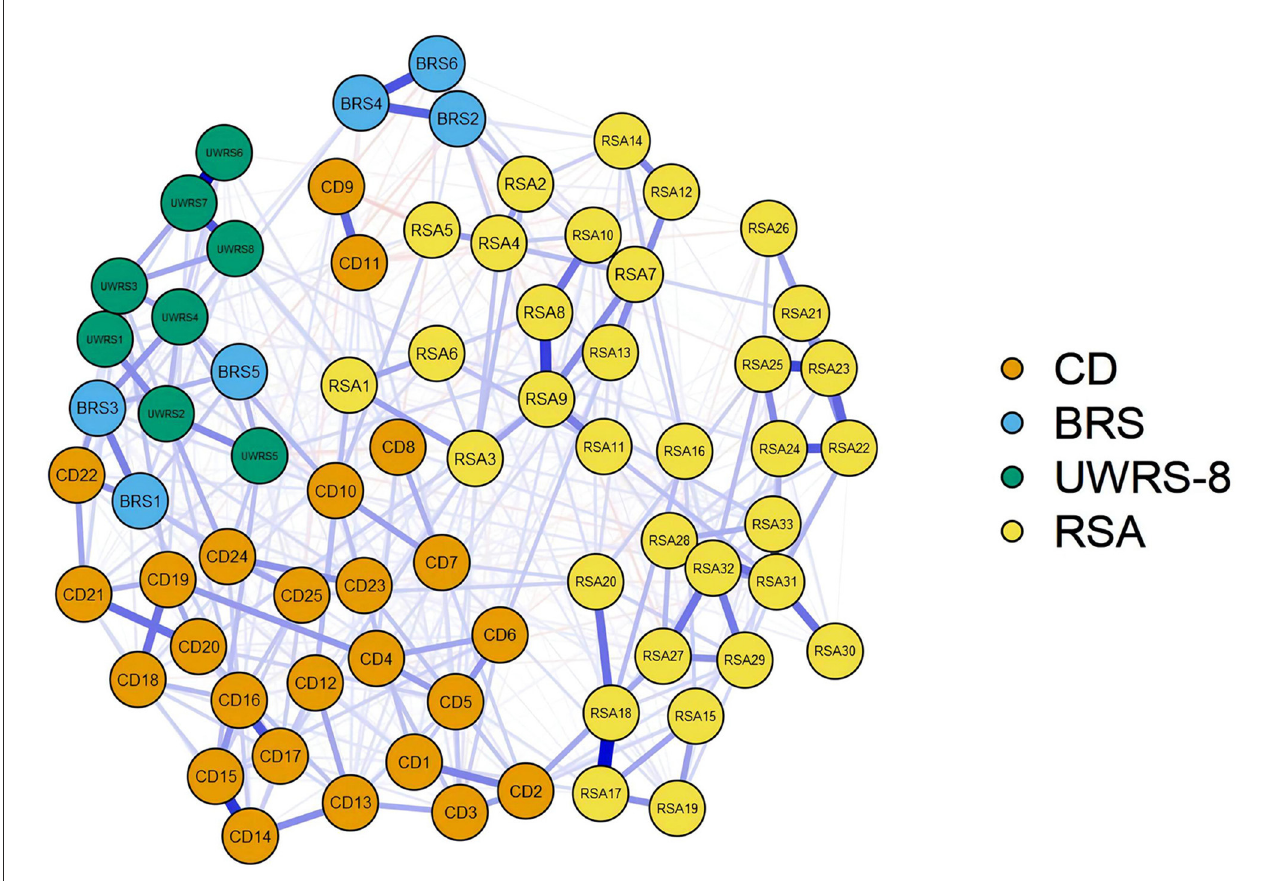
FIGURE3 Resilience structure network analysis of CD-RISC, UWRS-8, BRS, and